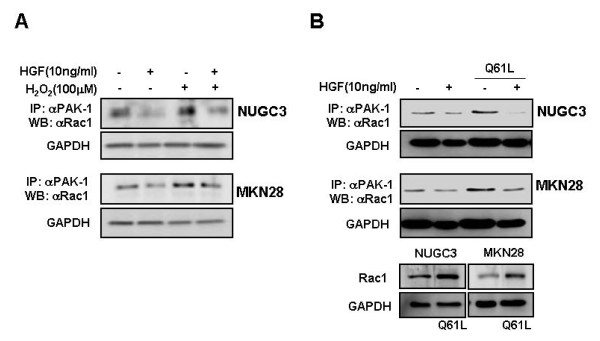
Effects of HGF and H2O2/LY 294002 on Rac-1 activation. Serum-starved cells was pretreated with or without H2O2 (100 μM) for 30 min and then treated with or without 10 ng/ml HGF (A). Rac-1 dominant positive cells (Q61L) were treated with or without HGF (B). After incubation for 15 min, the cells were collected, washed, and then sonicated. Cell lysates were immunoprecipitated with PAK-1 PBD and Rac-1 activation was measured by Western blotting with a Rac-1 antibody. Representative data from three independent experiments were shown.